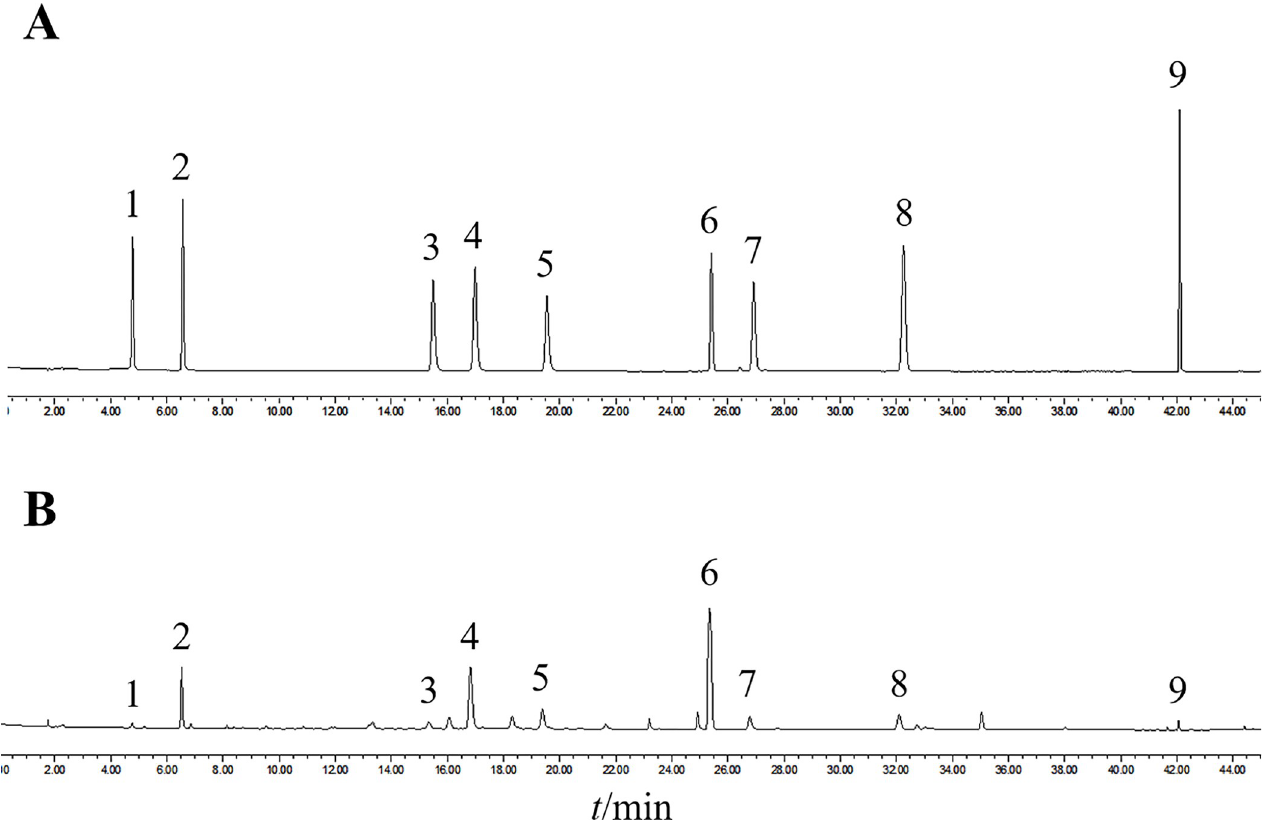
Fig 2. UPLC chromatograms of (A) the mixed reference solutions and (B) a CIF sample: 1, neochlorogenic acid; 2, chlorogenic acid; 3, isochlorogenic acid B; 4, isochlorogenic acid A; 5, isochlorogenic acid C; 6, linarin; 7, luteolin; 8, apigenin; 9, acacetin.